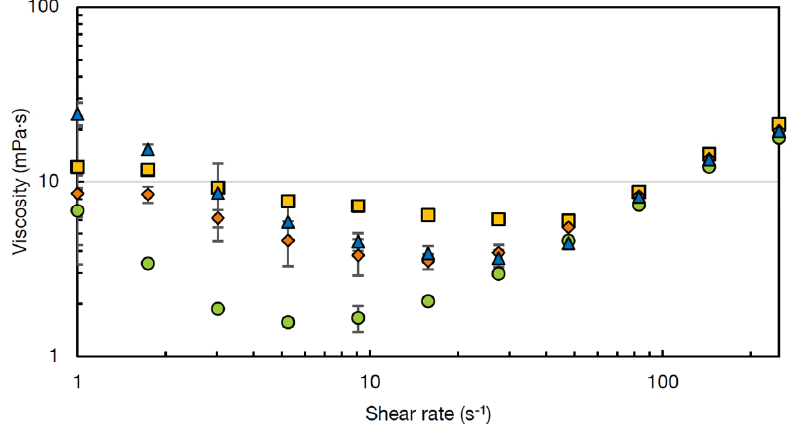
Figure 4. Viscosity curves at 60 ◦ C of instant soups containing potato starch (REF) ( (cid:4) ) or non- Figure 4. Viscosity curves at 60 °C of instant soups containing potato starch (REF) ( ◼ ) or non-gelatinised (NG-O) ( ◆ ), Figure 4. Viscosity curves at 60 °C of instant soups containing potato starch (REF) ( ◼ ) or non-gelatinised (NG-O) ( ◆ ), gelatinised (NG-O) ( Figure 4. Viscosity curves at 60 °C of instant soups containing potato starch (REF) ( ◼ ) or non-gelatinised (NG-O) ( ◆ ), ), pre-gelatinised (PG-O) ( • ) or commercial pre-gelatinised (INS) ( (cid:78) ) chickpea pre-gelatinised (PG-O) ( ● ) or commercial pre-gelatinised (INS) ( ▲ ) chickpea flour at medium concentration, showing pre-gelatinised (PG-O) ( ● ) or commercial pre-gelatinised (INS) ( ▲ ) chickpea flour at medium concentration, showing pre-gelatinised (PG-O) ( ● ) or commercial pre-gelatinised (INS) ( ▲ ) chickpea flour at medium concentration, showing viscosity ( η ) as function of shear rate ( γ̇ ). viscosity ( η ) as function of shear rate ( γ̇ ). flour at medium concentration, showing viscosity ( η ) as function of shear rate ( viscosity ( η ) as function of shear rate ( γ̇ ).